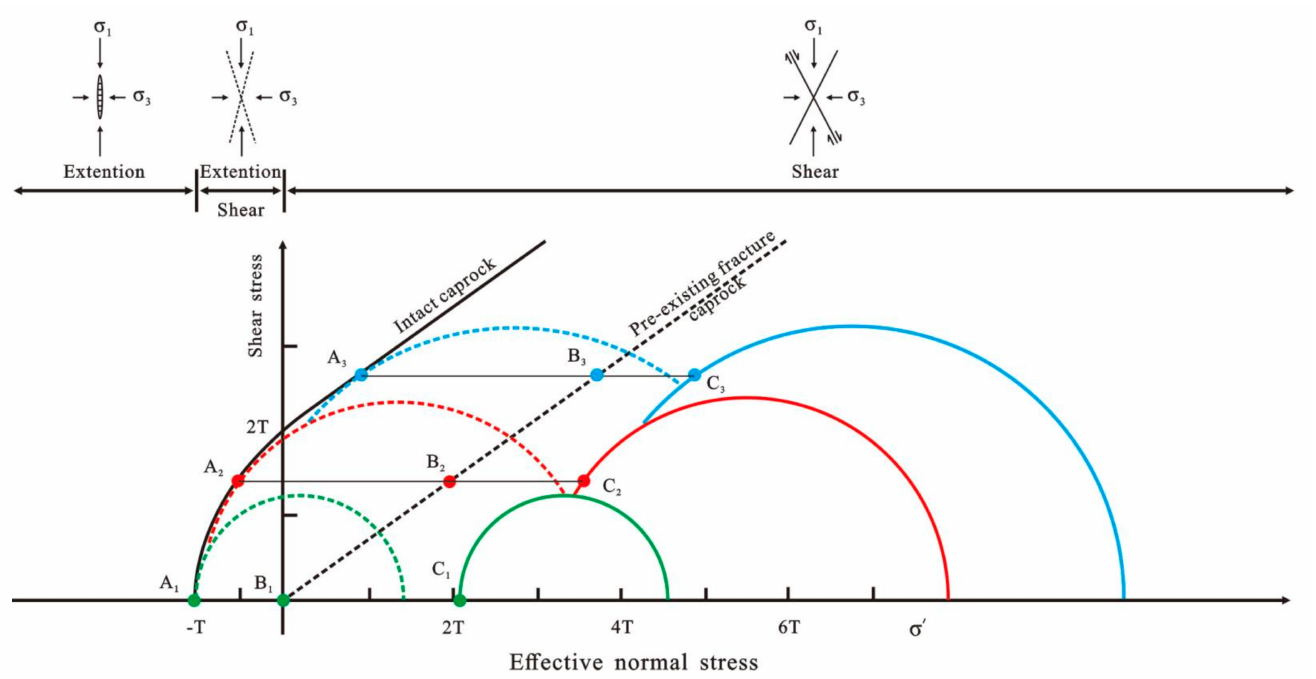
Figure 4. Hydraulic fracture pressure for the cap rock in different stress and mechanical properties. The Mohr circles, from large to small, indicate the critical conditions of shear, extension-shear and extension fracture of intact cap rocks and fractured cap rocks, and the corresponding maximum sustainable fluid pressures are A 1 C 1 , A 2 C 2 , A 3 C 3 and B 1 C 1 , B 2 C 2 , B 3 C 3 (modified by